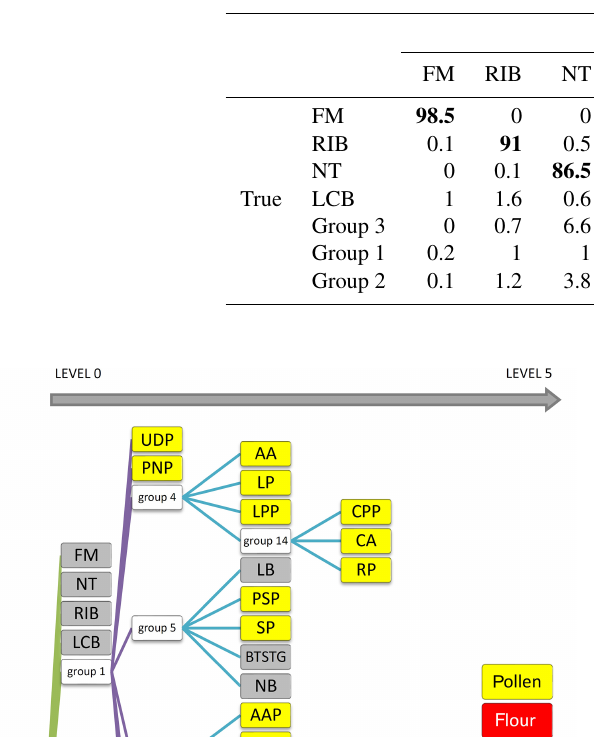
Table 3. Exemplary confusion matrix of all aerosols classified by the first ANN. Bold numbers denote how correct (in percent) a certain substance was classified to be.